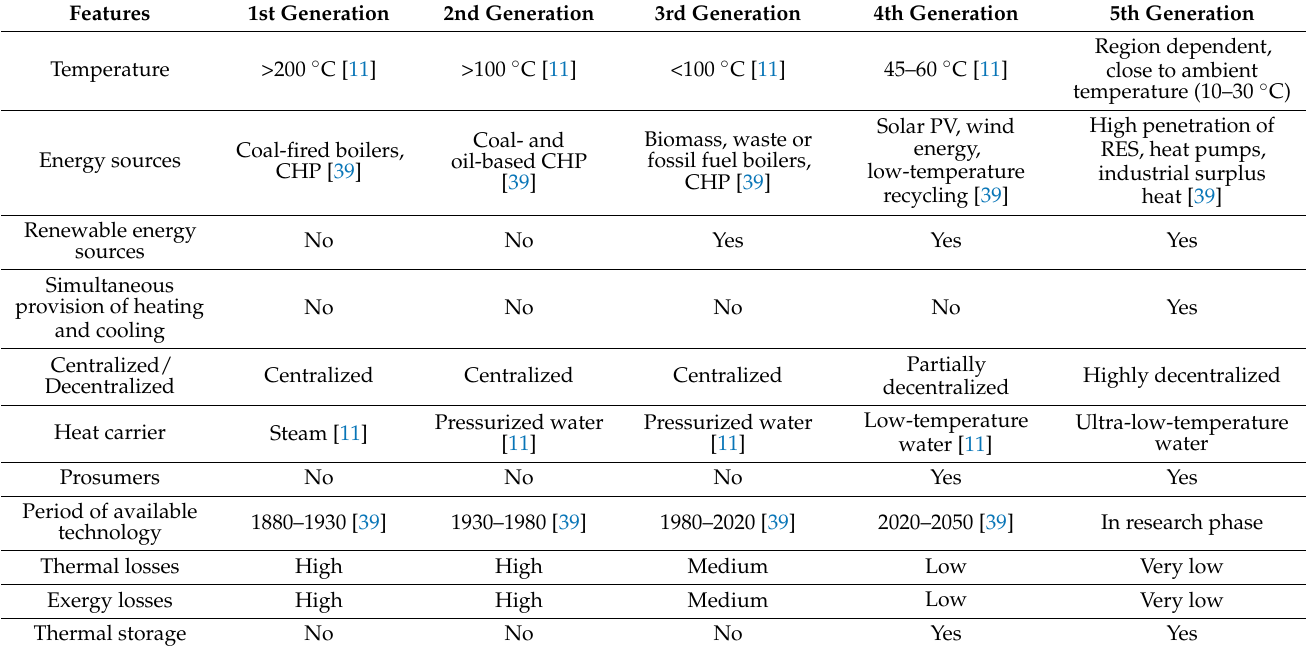
Table 1. Features of DH generations [39,42].